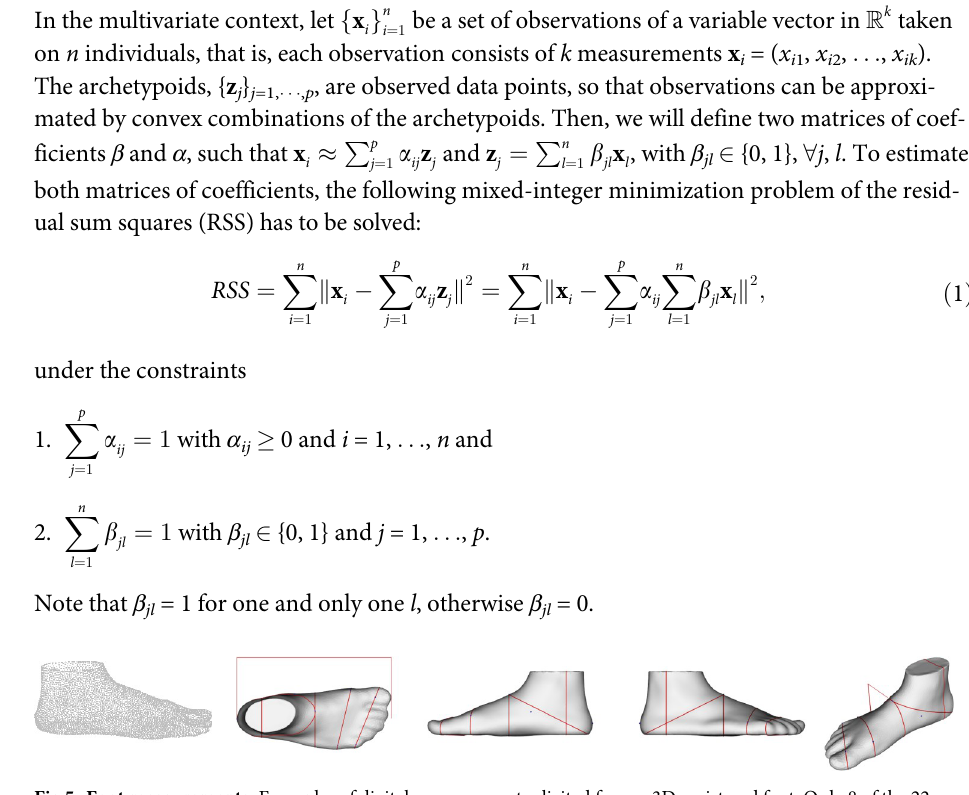
Fig 5. Foot measurements. Examples of digital measurements elicited from a 3D registered foot. Only 8 of the 22 measurements will be used in Section 3, where they will be described in detail. These 8 measurements correspond to the variables that could most influence shoe fitting according to shoe design